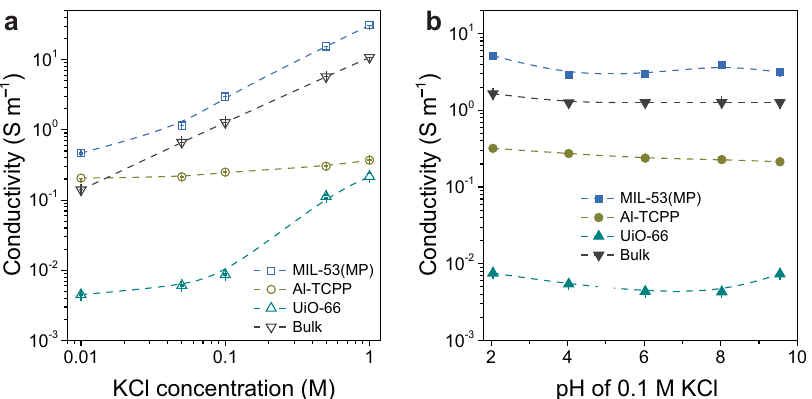
Fig. 4 | Effectsofconcentrationand pH ontheion transport propertiesin MOFchannels.a ConductivitiesofKClinMOFchannels measured in 0.01 – 1.0M solutions. b Conductivities of KCl in MOF channels at 0.1M solution with pH values from 2 – 10. Error bars represent the standard deviation of three measurements of a